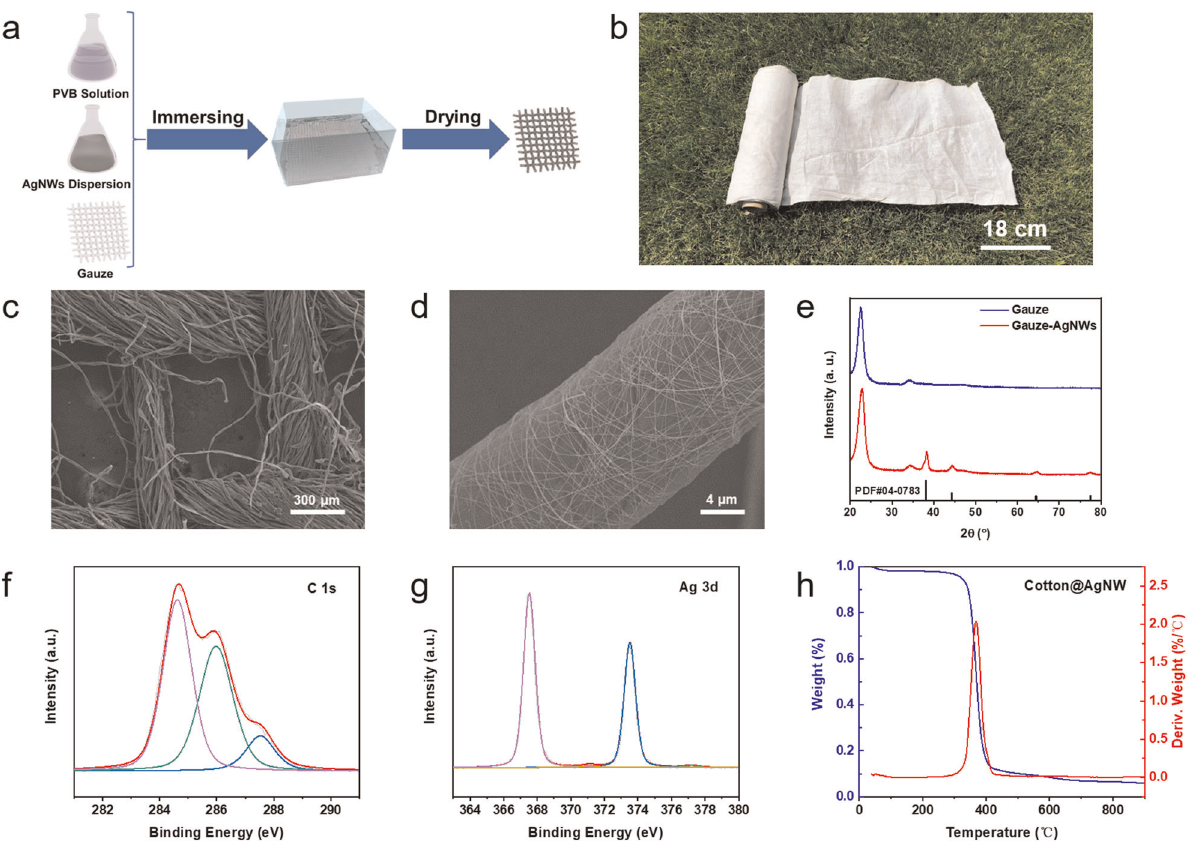
Fig. 2 The preparation process for AgNWs/PVB textile and properties of materials. a AgNWs/PVB textile preparation process schematic. b Photograph of a roll of AgNWs/PVB textile. c SEM image of a unit cell of the AgNWs/PVB textile. d SEM image of a single skeleton of the AgNWs/PVB textile. e XRD spectrum of AgNWs/PVB and pure textile. Chemical bond analysis of the surface of AgNWs/PVB textile using XPS, including peak-differentiation-imitating analysis of f C1s and g Ag3d. h TGA (blue) and DSC (red) results for AgNWs/PVB textile from room temperature to 900